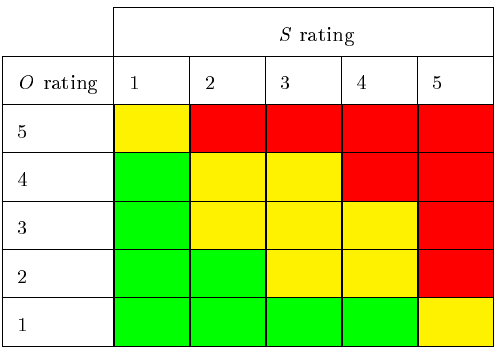
Tab. 5: Hammed and Khan [17] risk